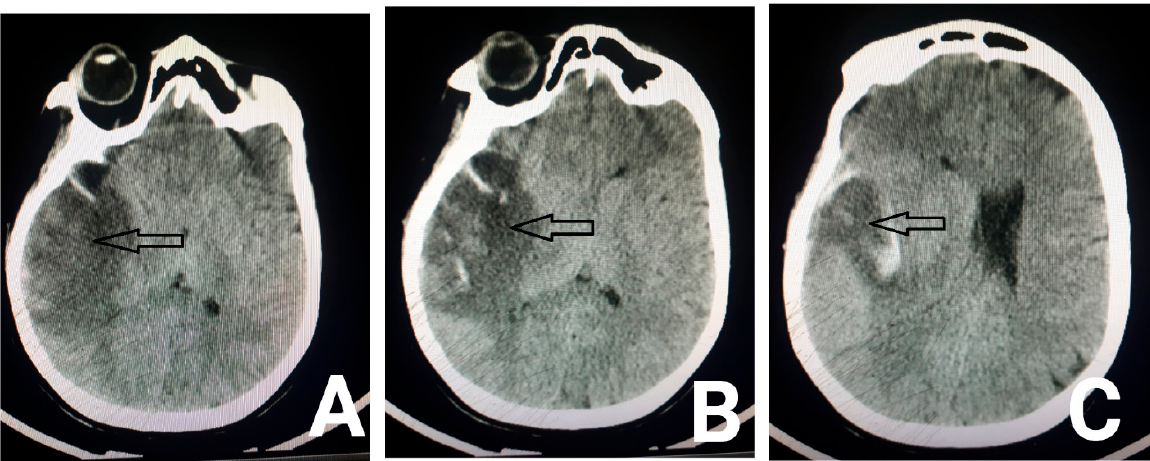
Figure 1. Axial brain CT scan shows hypodensity in the right temporal lobe (arrows in figure ( A ) and ( B )) in the drainage territory of the vein of Labbe, indicating venous infarct with parenchymal hemorrhage (arrow in figure ( C )).